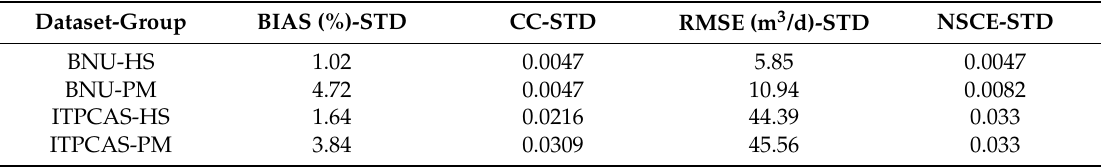
Table 4. Standard derivation (STD) of statistical metrics for CREST model with different spatial resolutions of PET by using HS and PM method for BNU and ITPCAS datasets, respectively. Dataset-Group BIAS (%)-STD CC-STD RMSE (m 3